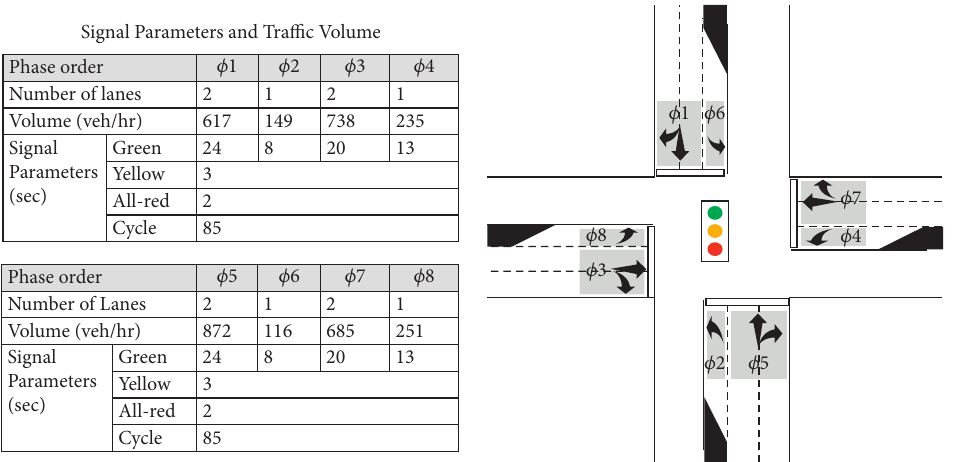
Figure 11: Detailed signal parameters and traffic volume